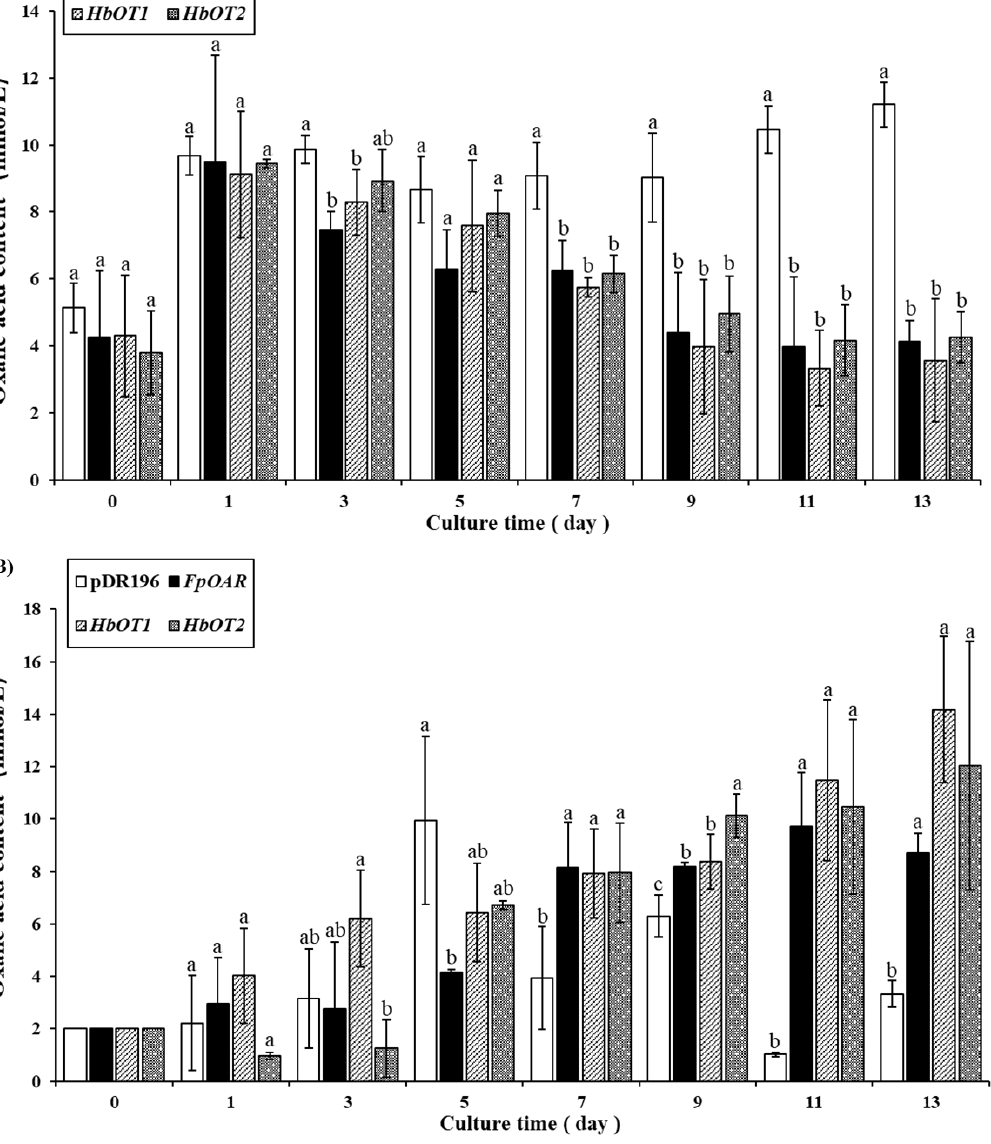
Figure 7. Changes of oxalic acid contents in medium and cells of yeast transformants under 2 mmol/L oxalic acid stress. ( A ) Oxalic acid content in yeast cells. ( B ) Oxalic acid content in the culture medium. Different letters indicate significant difference among different treatments at p < 0.05.